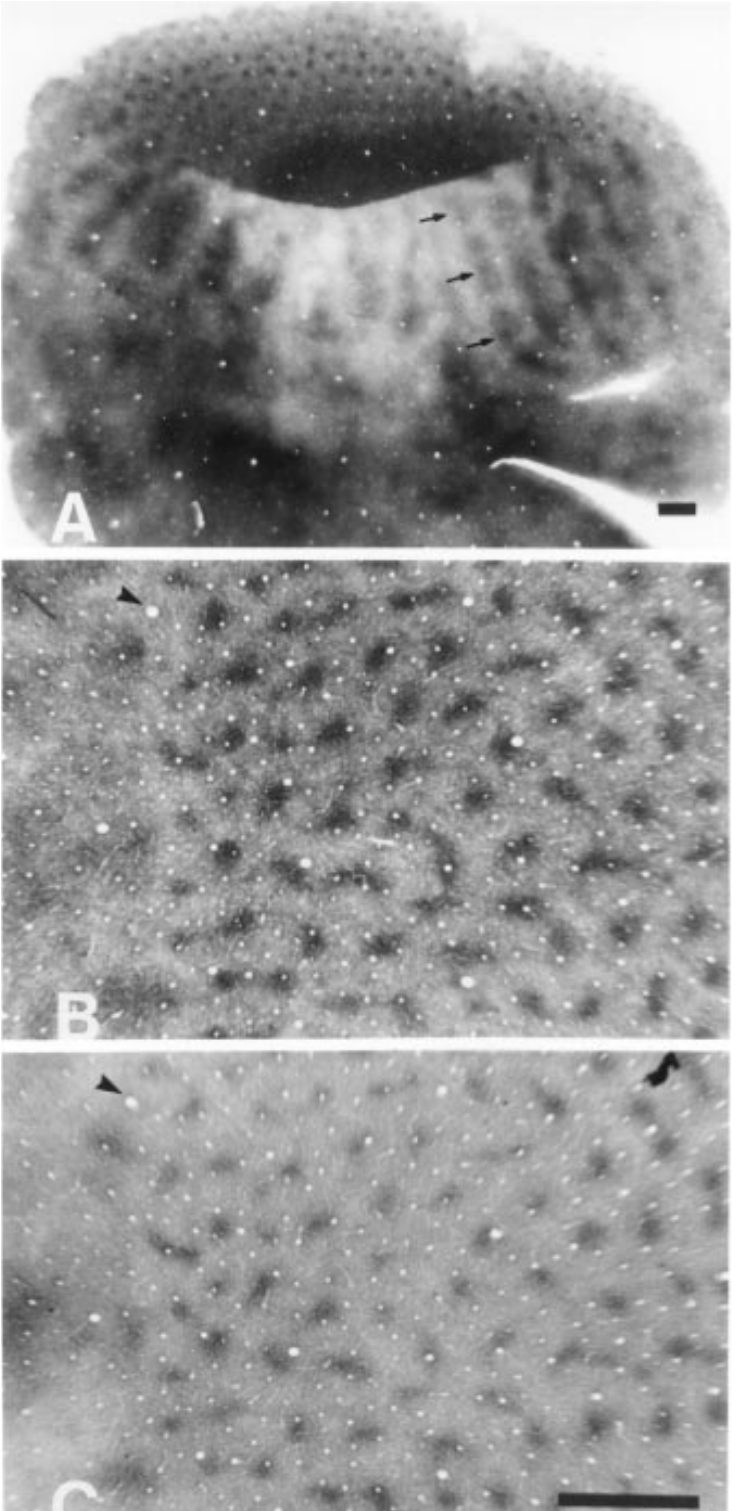
Figure 2 - Tangential sections through opercular supra- granular layers of V1. A , Low magnification photomi- crograph of a tangential section reacted for NADPH diaphorase. The blobs can be seen as small dots in V1. Different from the anterior limit of V2 with other extra- striate areas, the V1/V2 border is sharply defined. V2 stripes are also evident and present irregular enzymatic activity (arrows) along their extent. B , Section stained for NADPH diaphorase. C , Section processed for cyto- chrome oxidase. The arrowheads in B and C point to corresponding blood vessels. Scale bar = 1.0